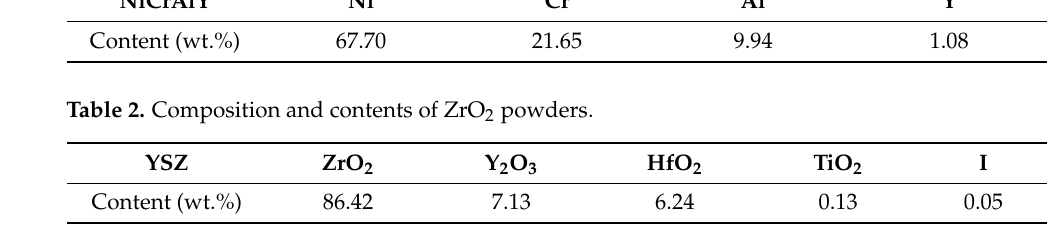
Table 3. Process parameters of NiCrAlY-ZrO 2